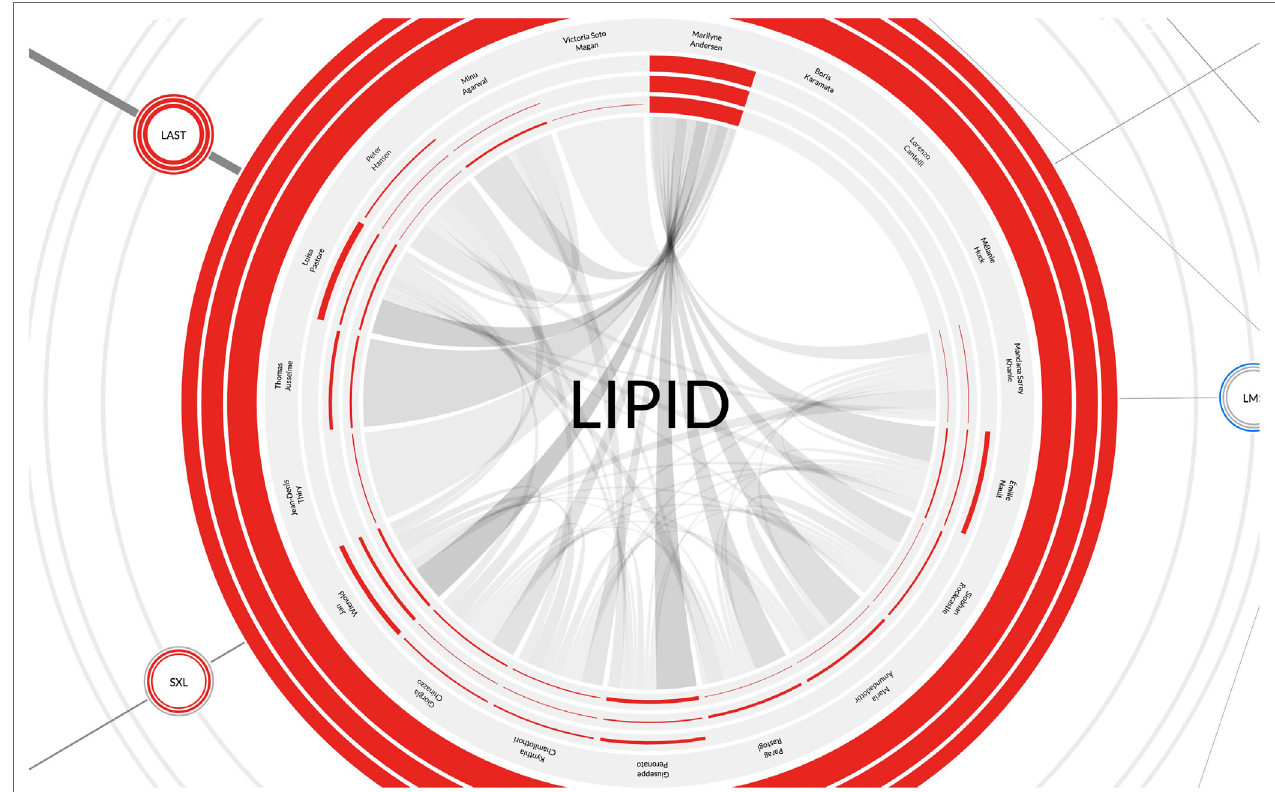
FigUre 5 | The laboratory node is represented as a network. A chord diagram shows the affinities among the members of the same unit. Then, the usual system of indicators corresponding to advising, publications, and teaching identifies the role of each member (segments of the circumference), and the balance of academic practice of the laboratory (external